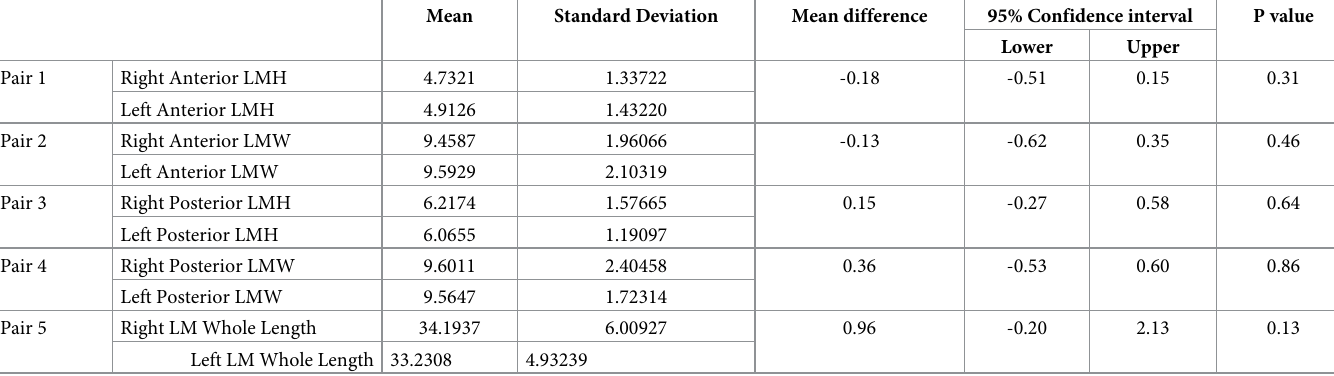
Table 3. Mean differences and the significance of the differences between left and right knee meniscal measurements in the lateral mid-sagittal